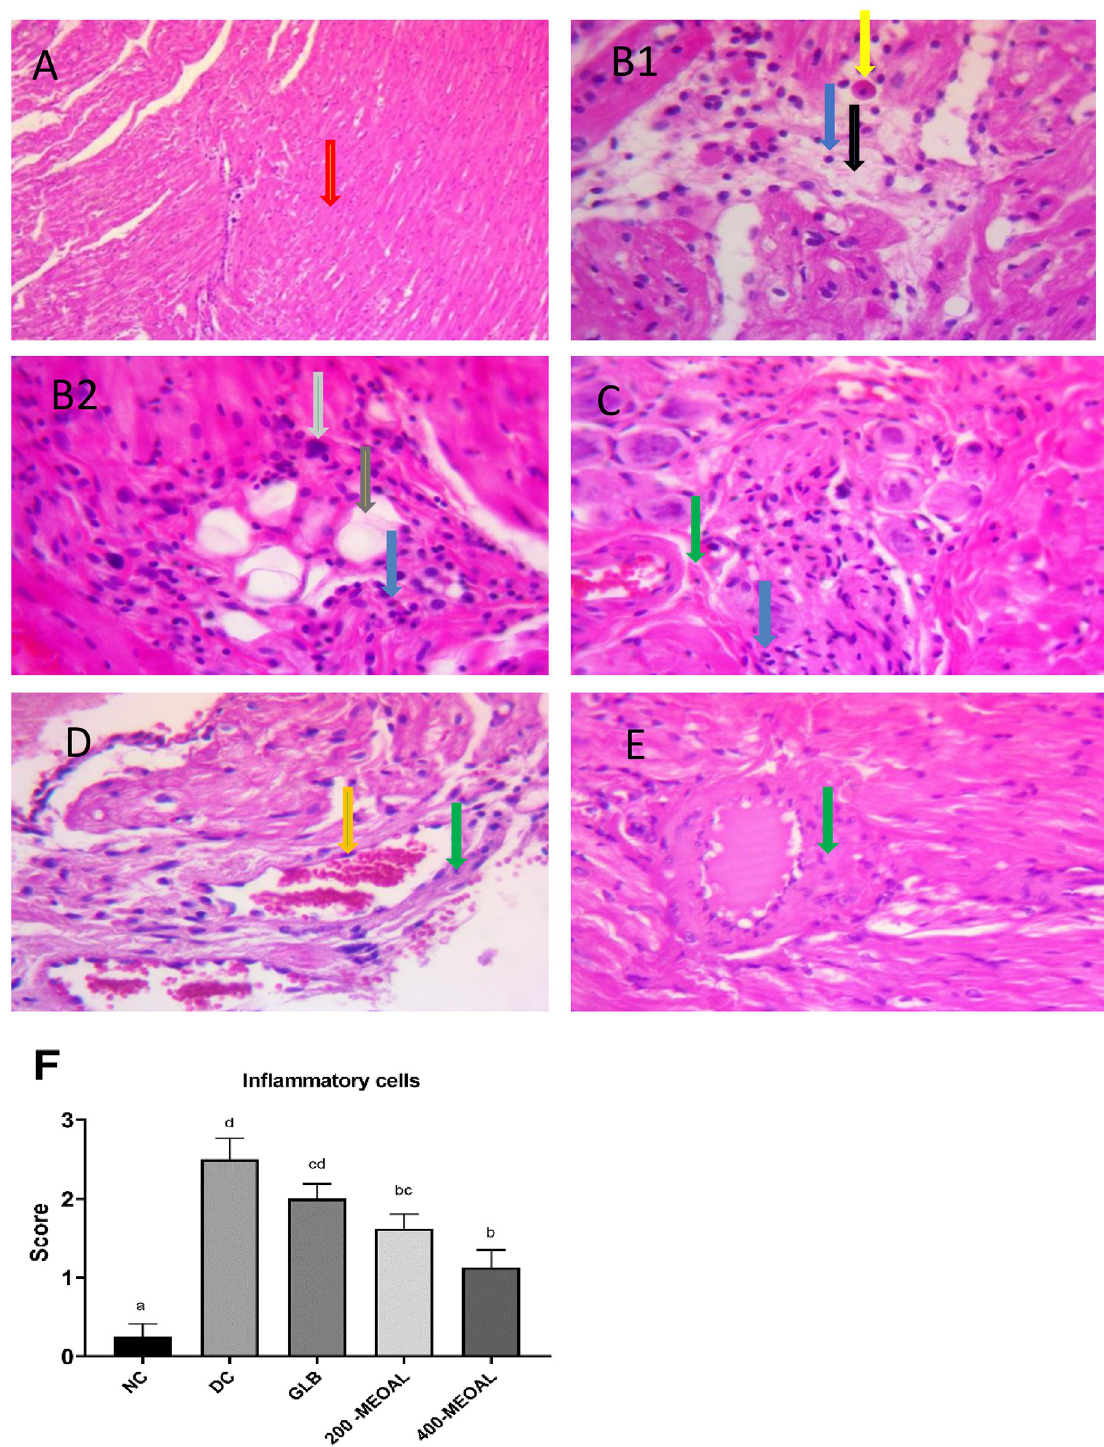
Fig 4. Effect of GLB or MEOAL on histopathological changes of myocardial tissue in different groups. Hematoxylin &Eosin staining sections under 40X magnification. https://doi.org/10.6084/m9.figshare.21828852.v1. Photomicrograph of myocardium from; (A) Normal control group showing healthy myocardial structure with normal myocyte (red arrow); (B1&B2) Diabetic control group showing significantly elevated in inflammatory cells infiltration (blue arrow) score compared to NC (P < 0.05, F). Marked edema (black arrow) appeared with pyknosis of myocyte (yellow arrow). Some of the hypertrophic myocytes with enlarged nucleus (grey arrow) and fatty